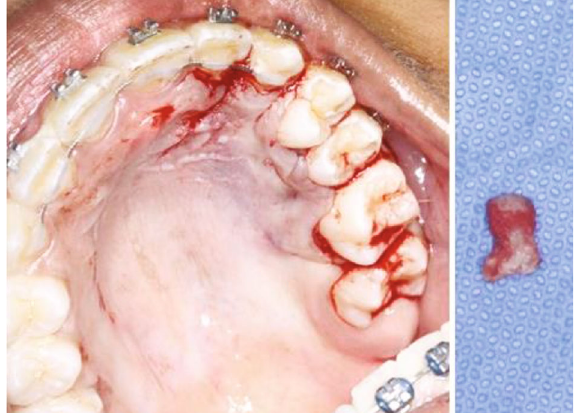
Figure 8: Removal of the supernumerary between the teeth 24 and